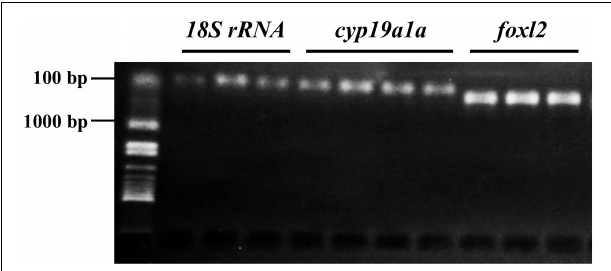
FIGURE 2 | Expression of sex differentiation-related gene foxl2 and cyp19a1a at 7 and 17 days posthatching (dph) in bluegill L. macrochirus . The leftmost sample in sample group of each gene was from 7 dph individual, and the rest two or three were from 17 dph individuals. The leftmost column was molecular size